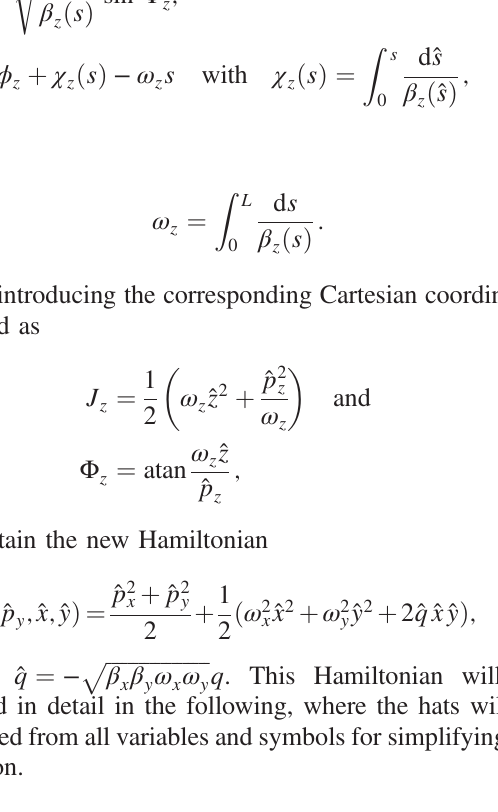
ffiffiffiffiffiffiffiffiffiffiffiffiffiffiffiffiffiffiffiffiffiffiffi p δ 2 λ Þ þ 4 q 2 2 ð